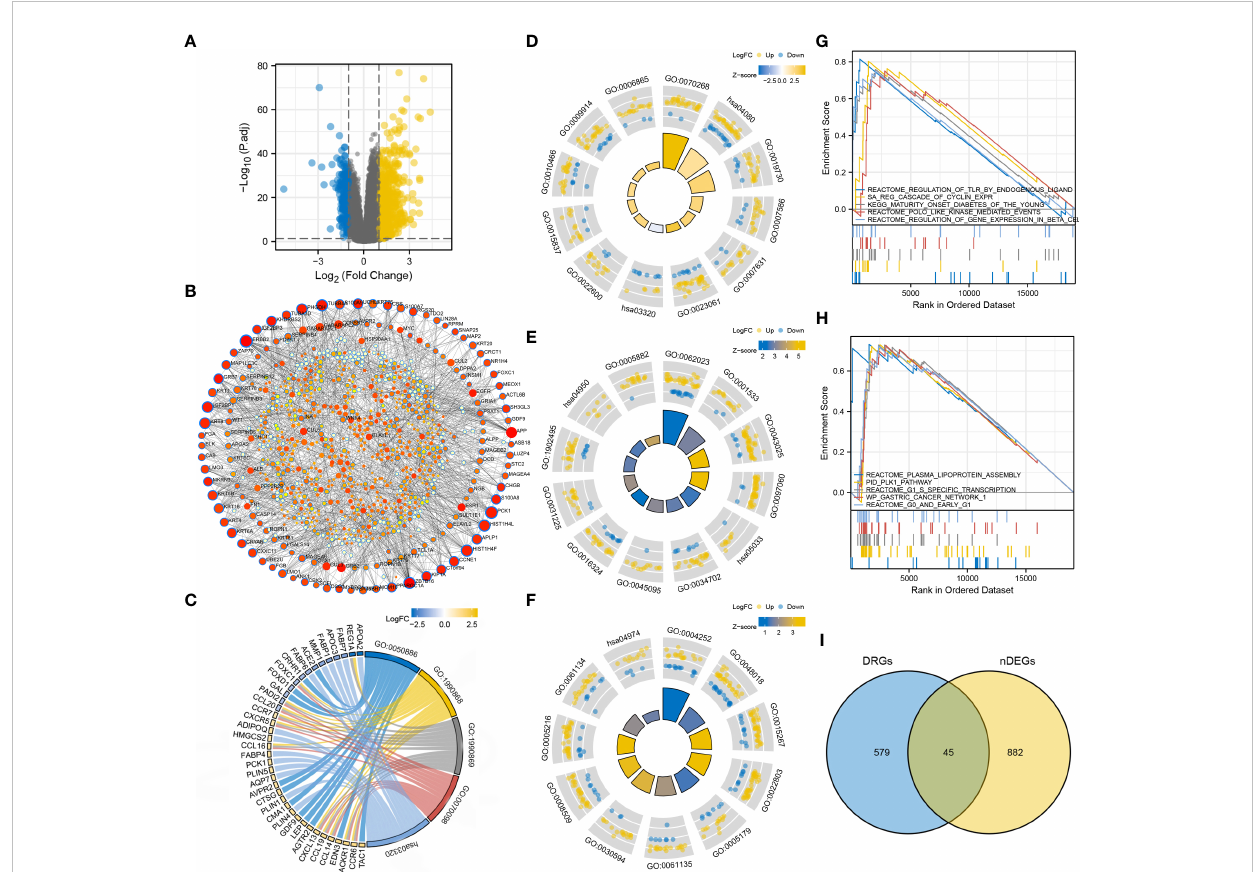
FIGURE 6 Functional characterization in the two risk groups. (A) DEGs between the low- and high-risk groups. (B) Tissue-speci fi c PPI network of the DEGs. Dots with blue borders represent nDEGs. Dots with a larger size and stronger colour intensity indicate nDEGs that play a more important role in the PPI network. (C) GO/KEGG biological activities that are signi fi cantly enriched in the low-risk group. (D – F) GO/KEGG biological activities that are signi fi cantly enriched in the high-risk group. (G, H) GSEA in the high-risk group. (I) Identi fi cation of DR-nDEGs.